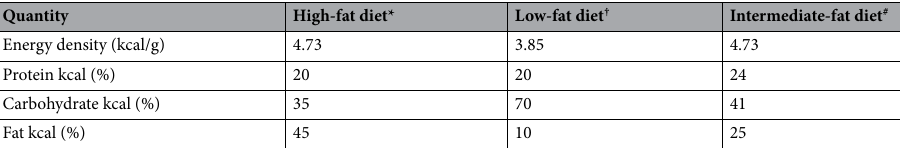
Table 1. Dietary formulations. High-fat diet* = D12451; low fat diet † = D12450B (both from OpenSource Diets); intermediate fat diet # = LabDiet 5001 Rodent Diet (PMI Nutrition Inc.). See Supplementary Information for more diet